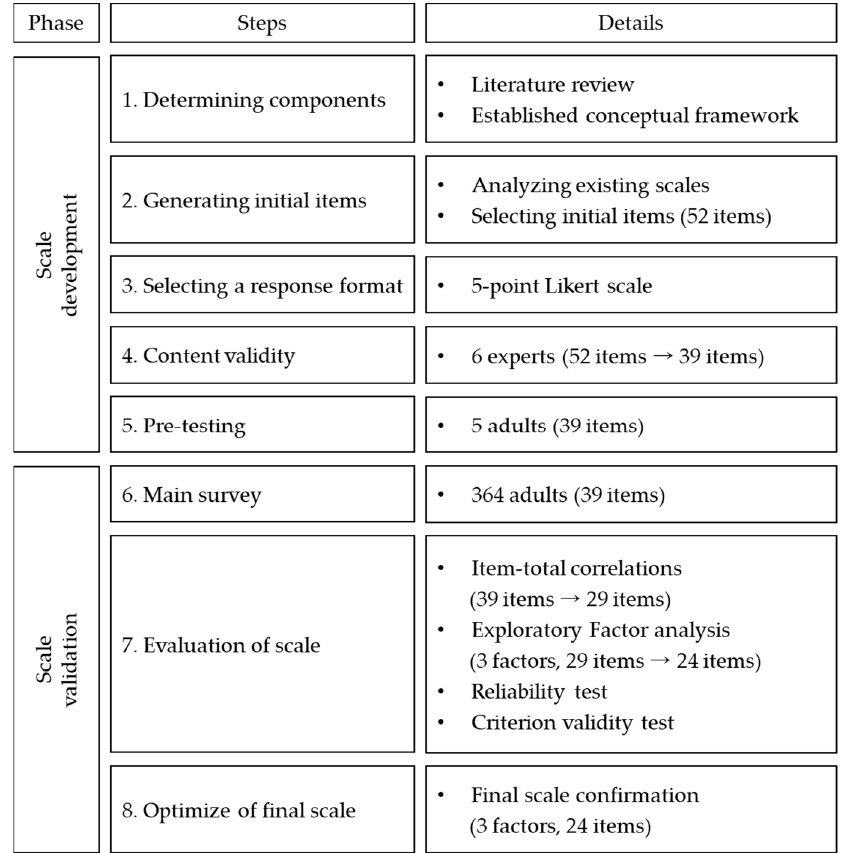
Figure 1. Steps of scale development and validation .